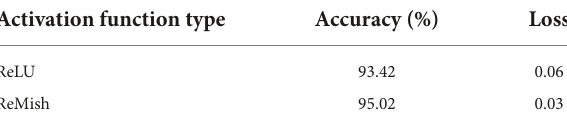
TABLE 8 Verifying the effectiveness of the improved activation function